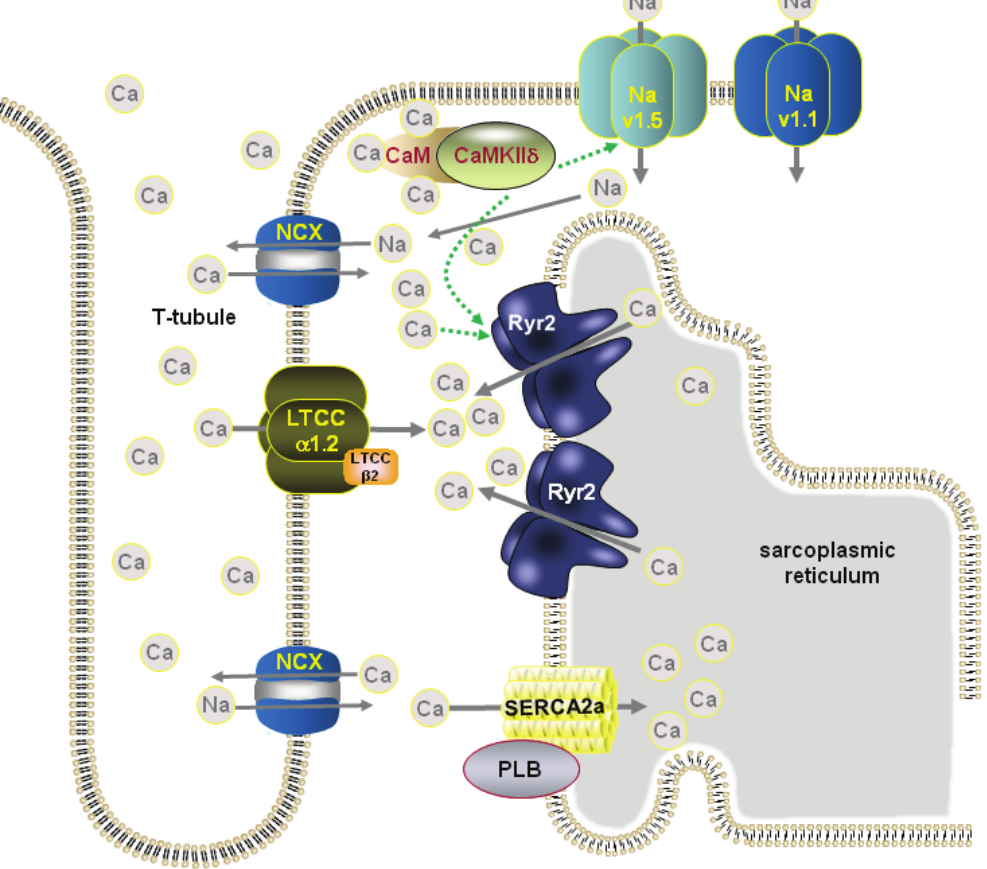
Figure 3. An increase in late Na current mediated by flux through the cardiac (Na leads to an increase in sub-sarcolemmal [Na] that reduces the efflux of Ca by NCX during the cardiac cycle. CamKII can phosphorylate Na which enhances the late Na v1.5